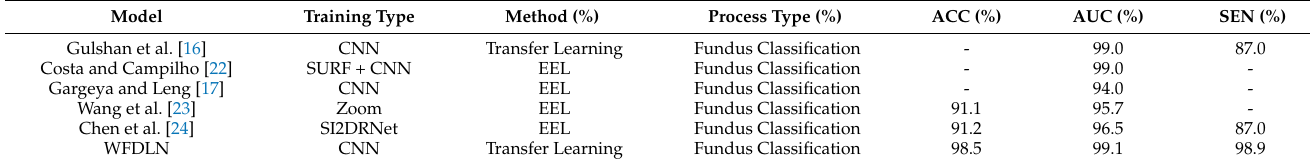
Table 4. Result comparison of our proposed model with up-to-date methods on the Messidor dataset for fundus classification. EEL stands for end-to-end learning.